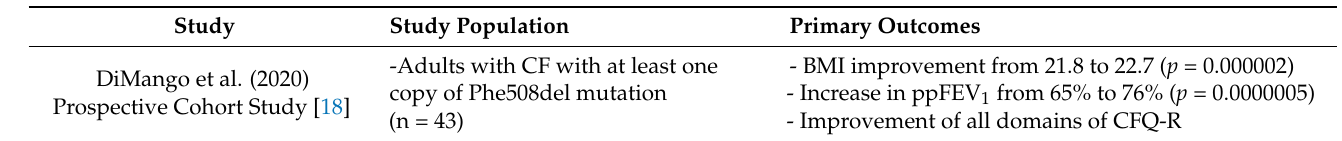
Table 2. Summary of characteristics and results of observational studies examing the effect of Elexacaftor/Tezacafor/Ivacaftor on different parameters in individuals with Cystic